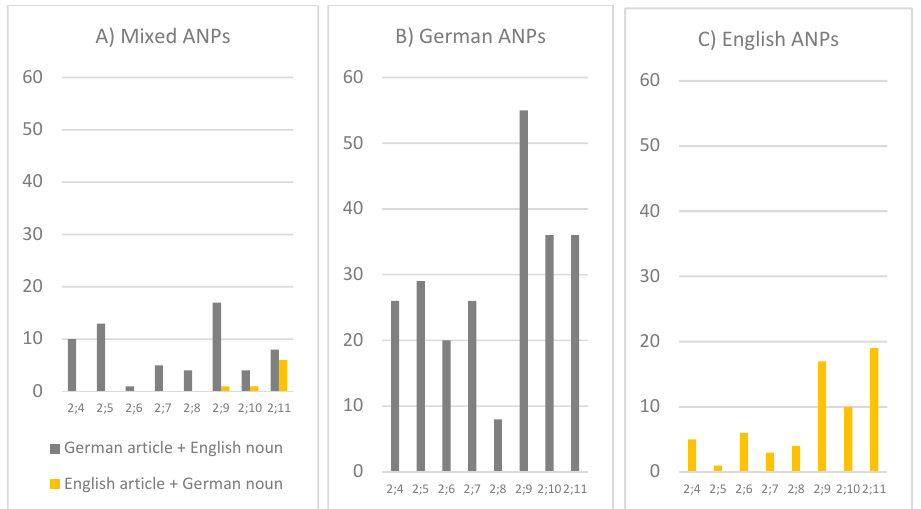
Figure 1. Frequency of use of ANPs in German-English, according to age .